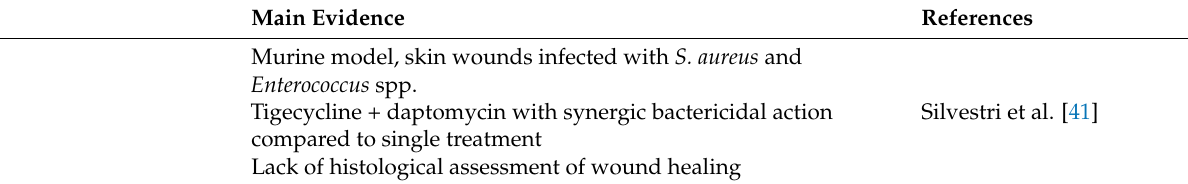
Table 1. Cont. Main